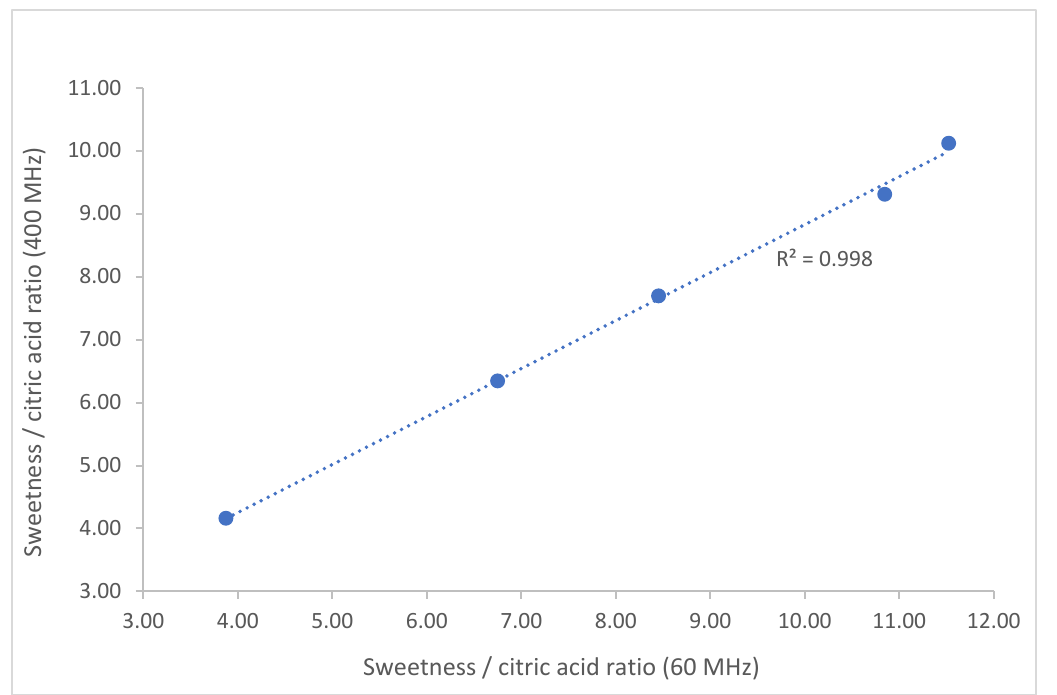
Figure 2. Correlation between the measurement of the sweetness/citric acid ratio of the samples obtained at 400 and 60 MHz.